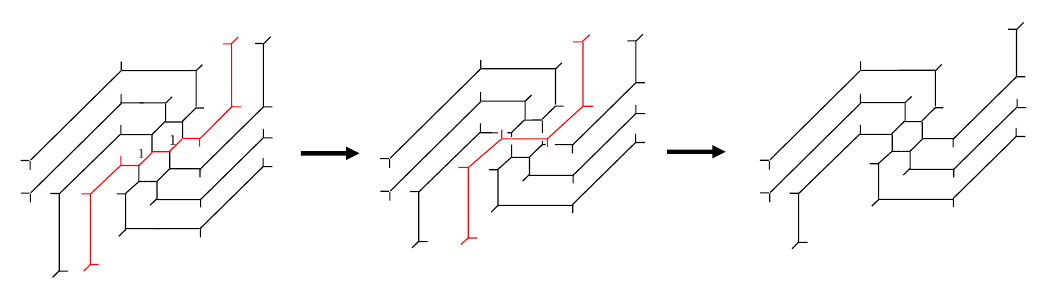
Figure 5 . Higgsing in a Tao diagram for SU(3) theory with 10 flavors. Since the framing denoted by the red lines decouples from the remaining web diagram, the part of the summation of the Young diagram is decoupled from other